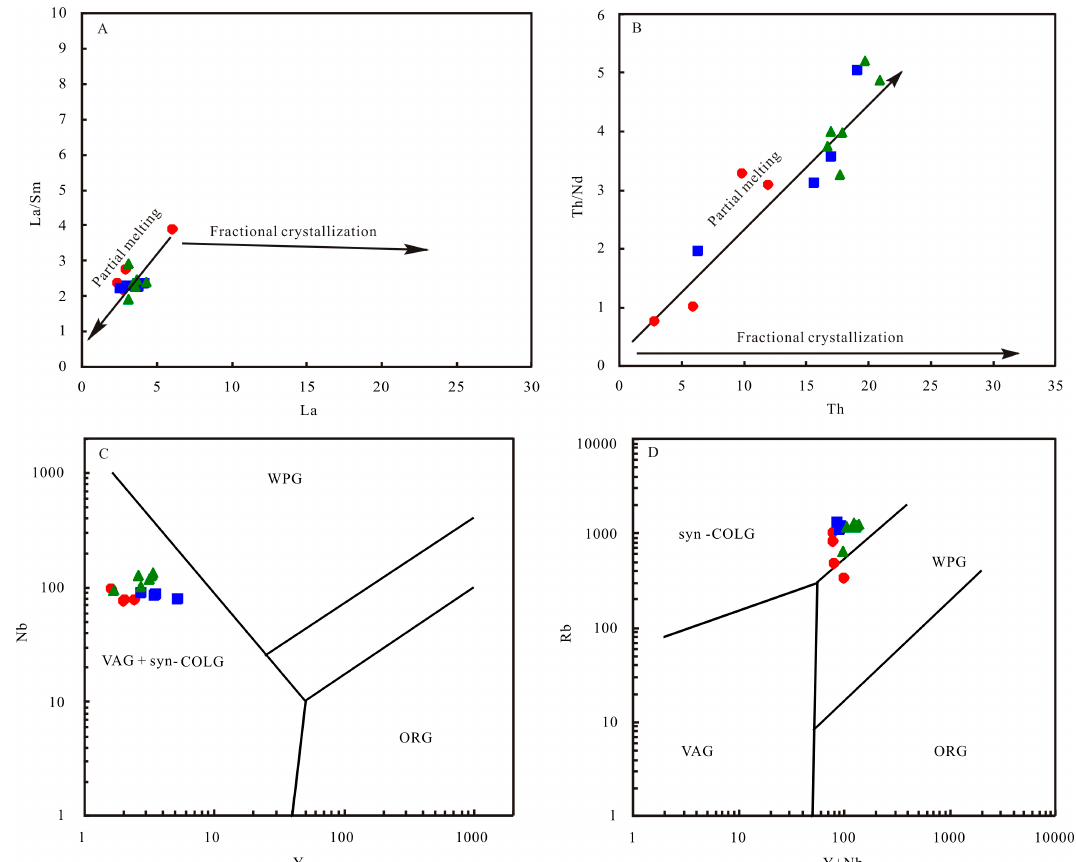
Figure 10. ( A ) La versus La/Sm diagram (Yang et al. [62]); ( B ) Th versus Th/Nd diagram (Schiano et al. [74]) ( C ) Y versus Nb diagram (Pearce et al. [75]); ( D ) Y + Nb versus Rb diagram (Pearce et al. [75]). Same symbols as Figure 8.